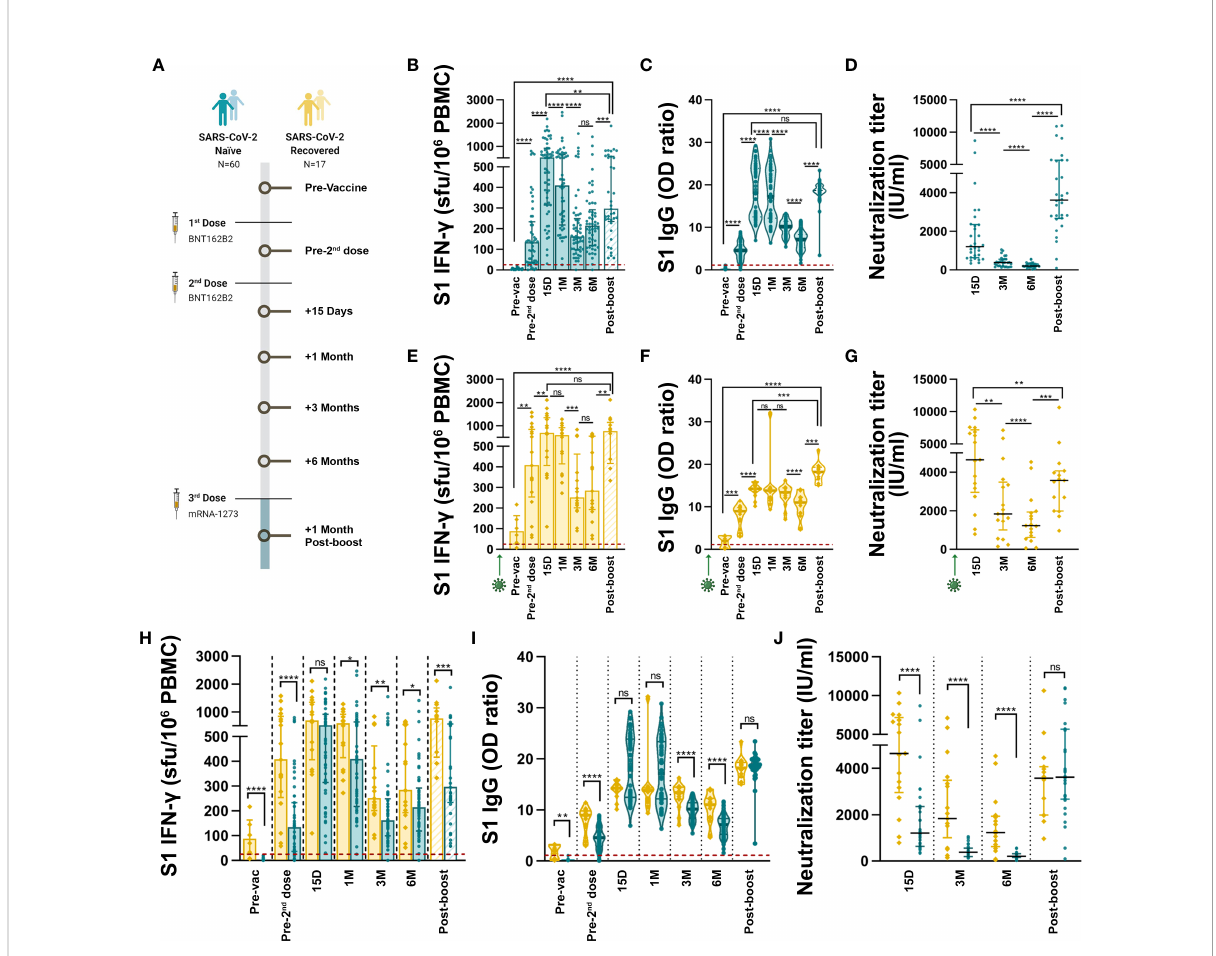
FIGURE 1 Development and maintenance of SARS-CoV-2-speci fi c cellular and humoral immunity after 3 mRNA vaccine doses. (A) Study design and cohorts, samples were collected pre-vaccine, 21 days after the fi rst dose, 15, 30, 90 and 180 days after the second dose and 30 days after third boost dose. (B) Dynamics of vaccine-triggered S1-IFN- g -producing T cell response in SARS-CoV-2 naïve individuals (in blue). Data is represented as spot forming unit (sfu) per million PBMC. Dashed lines represent the positivity cut-off established by using a non-infected control group: >25 sfu/10 6 PBMC. (C) anti-S1 IgG levels elicited by mRNA vaccination in SARS-CoV-2 naïve individuals. Dashed line represents the established cut-off of positivity: OD ratio ≥ 1.1. (D) Vaccine-triggered neutralizing activity in SARS-CoV-2-naïve serum samples,